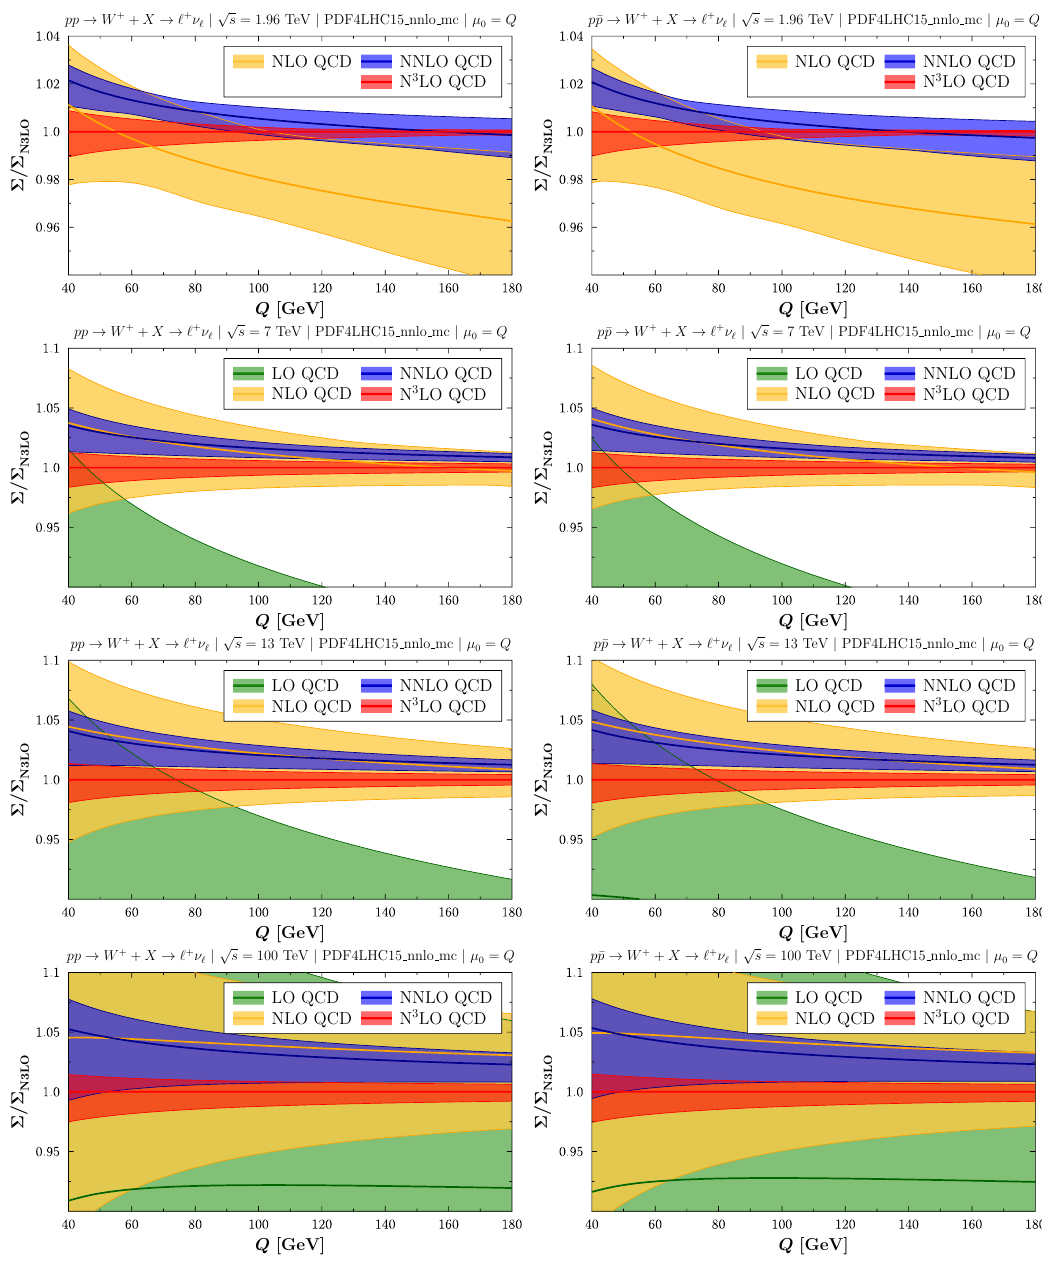
Figure 4 . Same as figure 3, but for W +